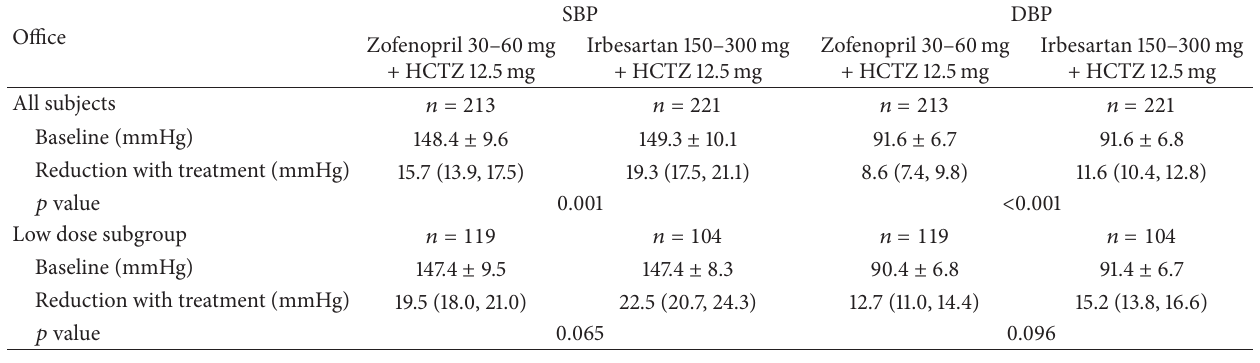
Table 2: Baseline-adjusted office systolic blood pressure (SBP) and diastolic blood pressure (DBP) reductions after 18 weeks of treatment with zofenopril + hydrochlorothiazide (HCTZ) or irbesartan + HCTZ in the whole study group and in the subgroup of patients treated with the low drug dose (zofenopril 30mg or irbesartan 150 mg). Data are shown for the intention-to-treat population and reported as mean ± SD or as mean and 95% confidence interval. The 𝑝 value refers to the statistical significance of the intertreatment difference.